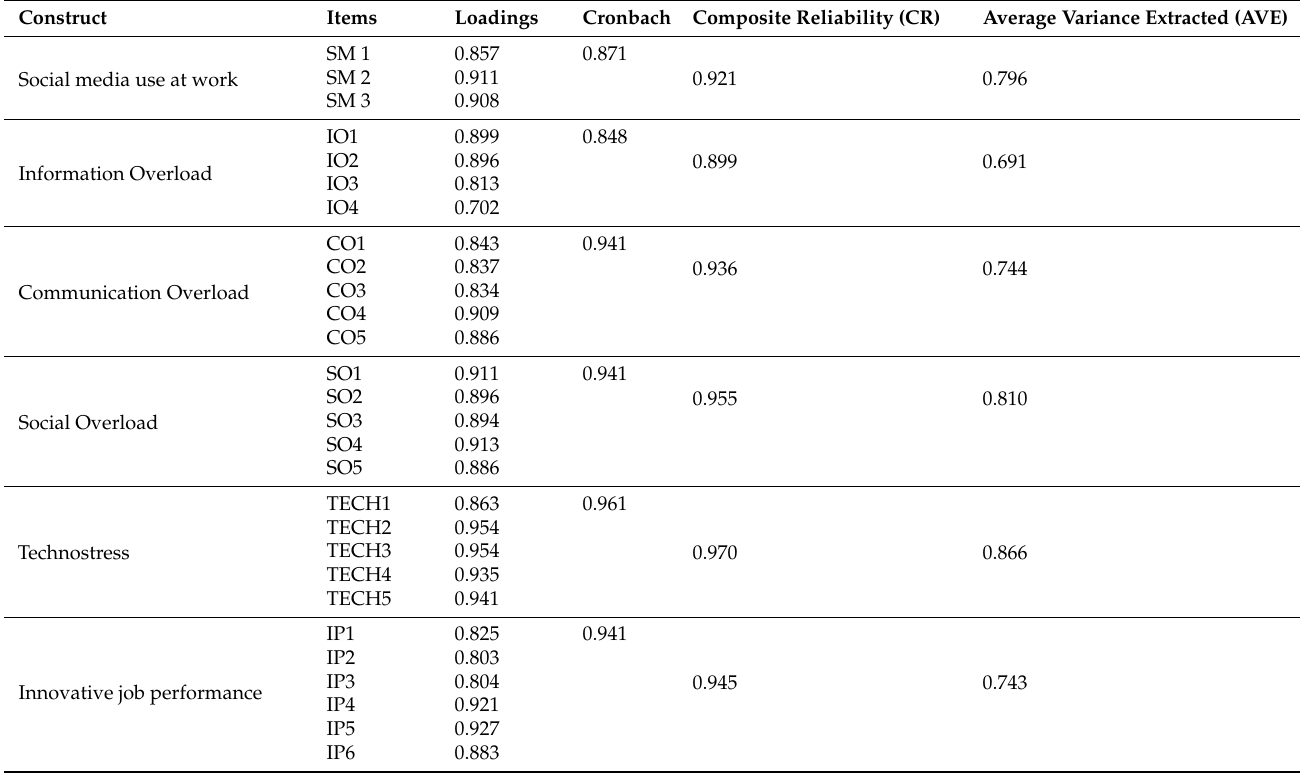
Table 5. Reliability and validity